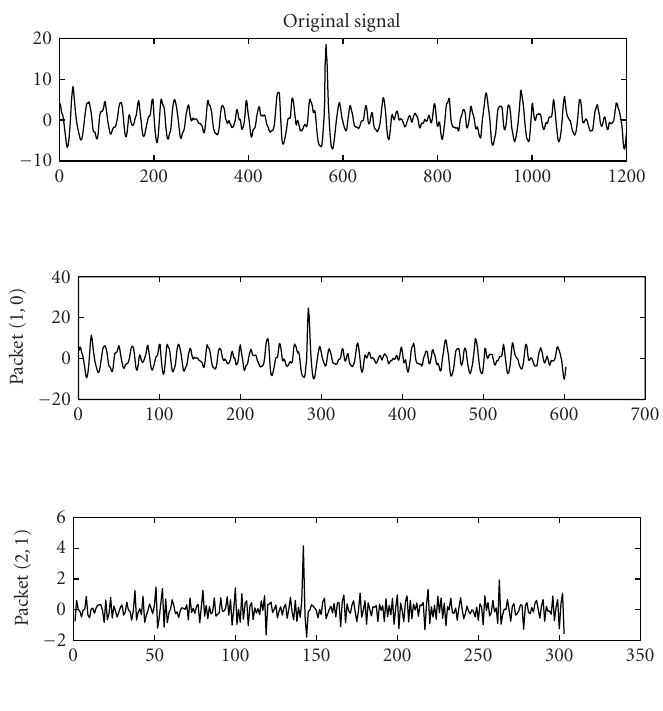
Figure 3.15. Wavelet packet with